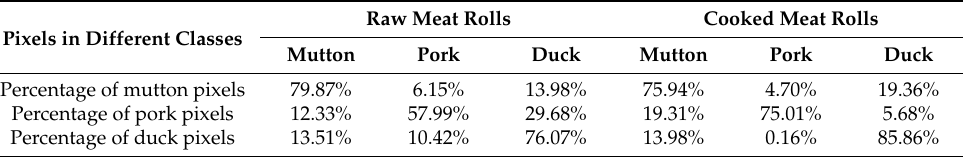
Table 4. Statistics of the number of classified pixels for the three meat roll classes. Raw Meat Pixels in Different Classes